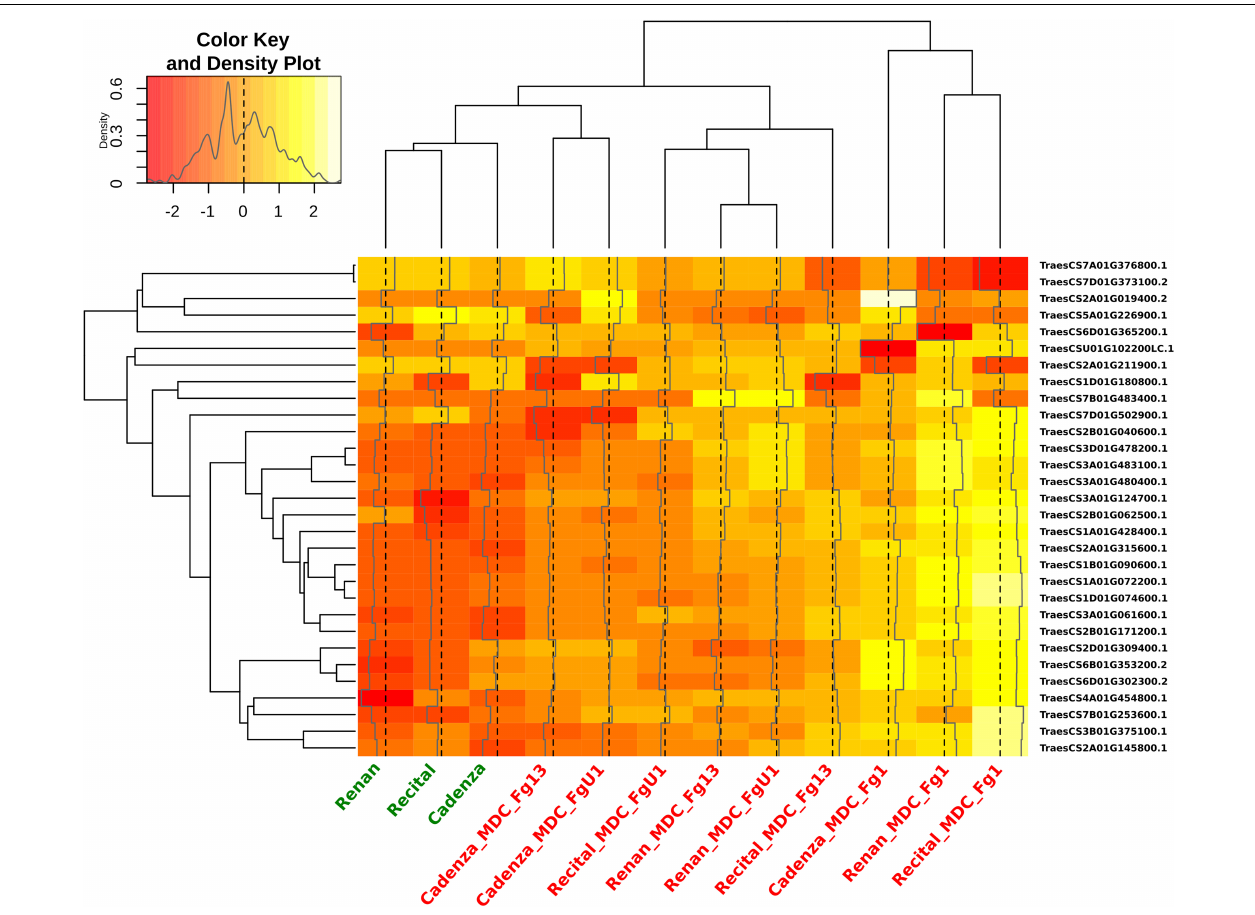
FIGURE 6 | Heat map indicating the abundance changes of the 30 wheat proteins showing significant abundance changes according to the interaction between the wheat cultivar and the inoculated fungal strain. For each cultivar × Fusarium graminearum strain combination (in red ) and control sample (in green ), hierarchical clustering was calculated from each protein Z -score transformed abundance values. The colors of the heat map indicate the abundance of each protein in each